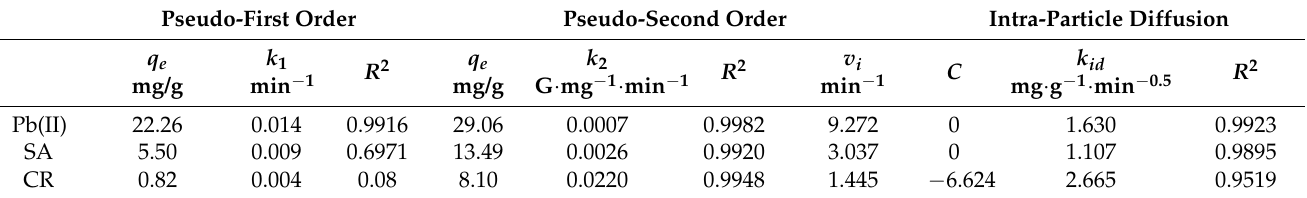
Table 3. Kinetic parameters for the adsorption of Pb(II), SA, and CR on CsXM. Pseudo-First Order